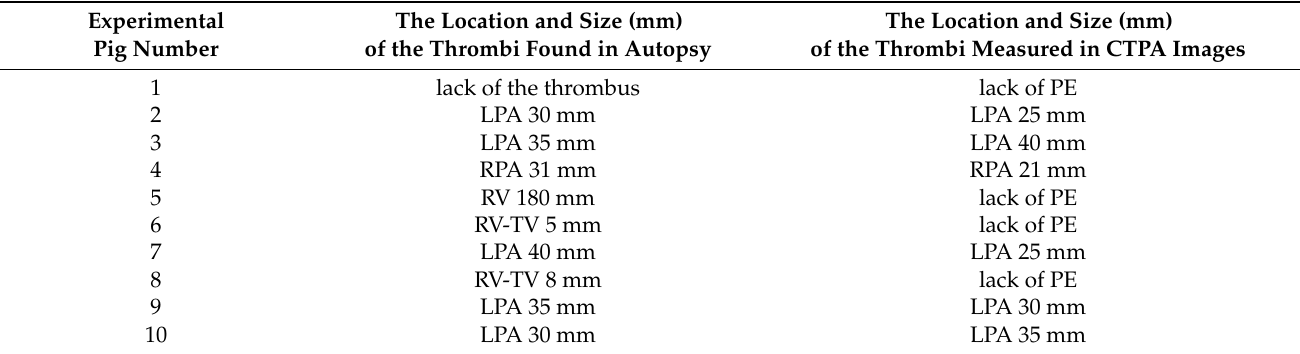
PE—pulmonary embolism, LPA—left pulmonary artery, RPA—right pulmonary artery, RV—right ventricle, TV—tricuspid valve, CTPA— computed tomography pulmonary